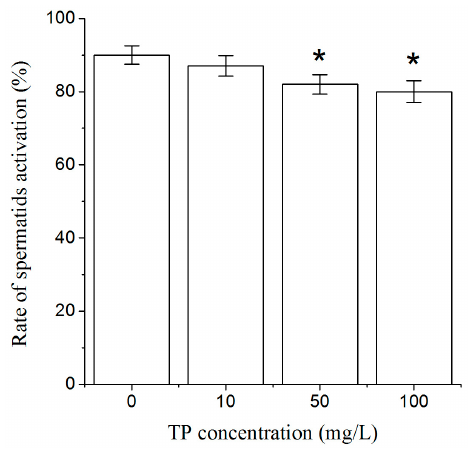
Figure 7. The rate of spermatids activation (%) of nematodes exposed to TP for 4 h. TP, Triptolide. Bars represent means ± SEM. * p < 0.05 vs. the control group.